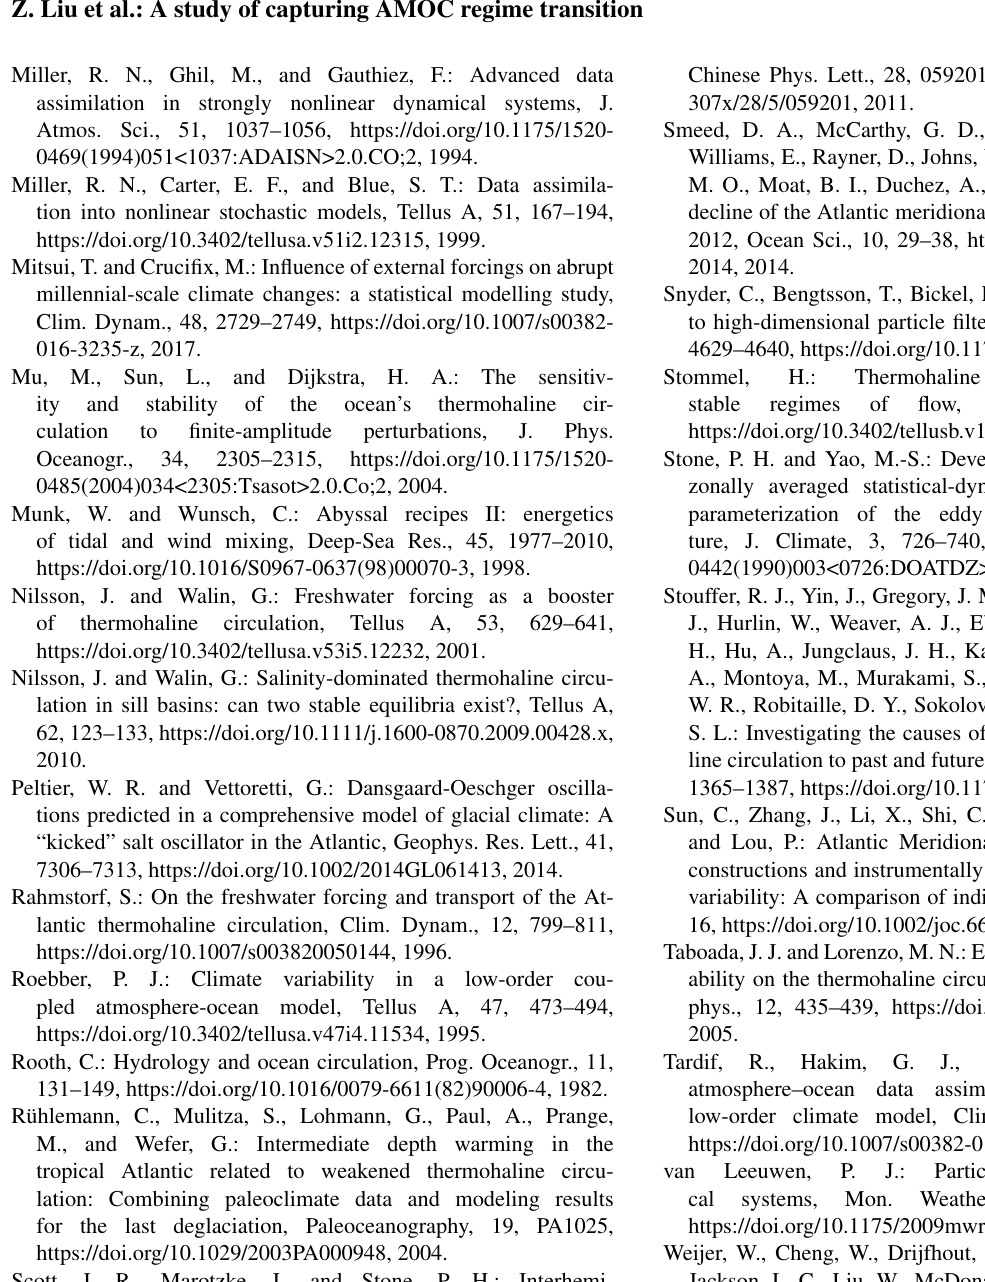
Taboada, J. J. and Lorenzo, M. N.: Effects of the synoptic scale vari- ability on the thermohaline circulation, Nonlin. Processes